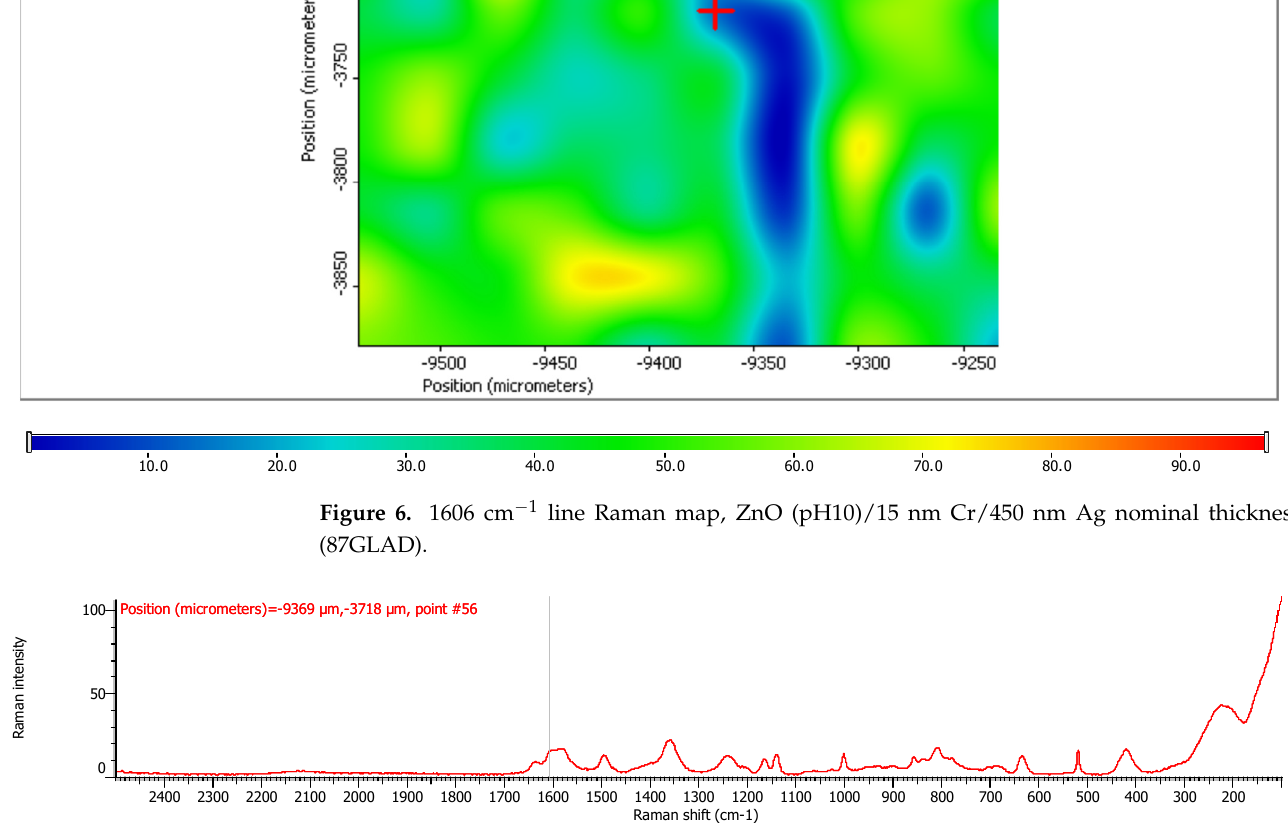
Figure 7. Raman spectroscopy on the position (micrometres) = − 9369 μ m, − 3718 μ m, point #56.